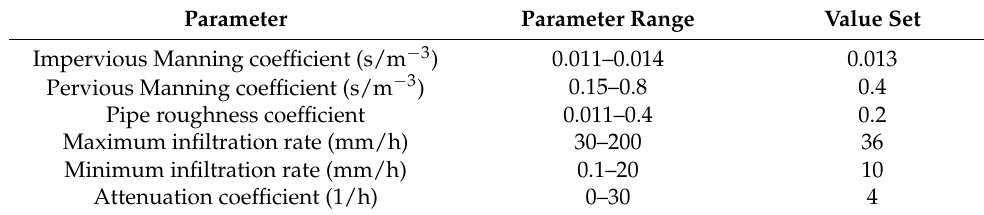
Table 2. List of the Model’s Parameters Set by Reference to